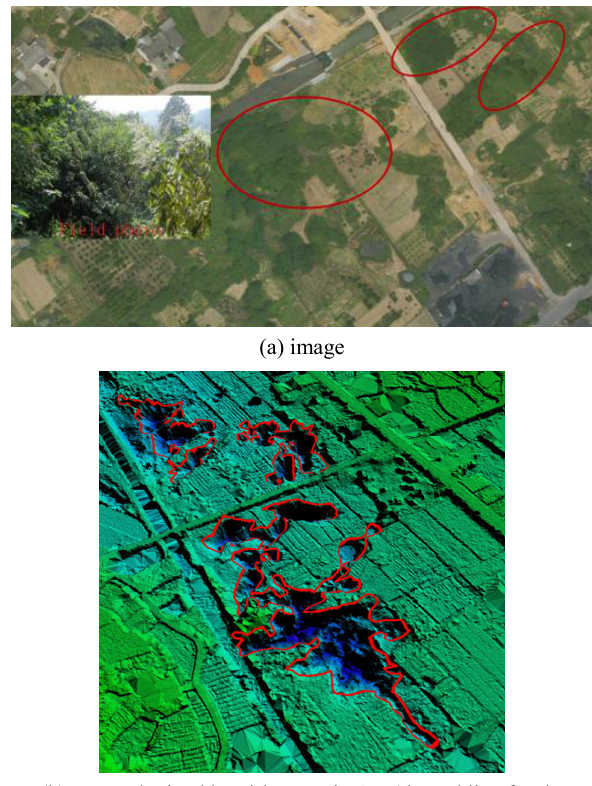
(b) DEM obtained by airborne LiDAR (the red line for the surface subsidence area and not collapse) Figure 1.Subsidence area of coal dam covered with dense vegetation